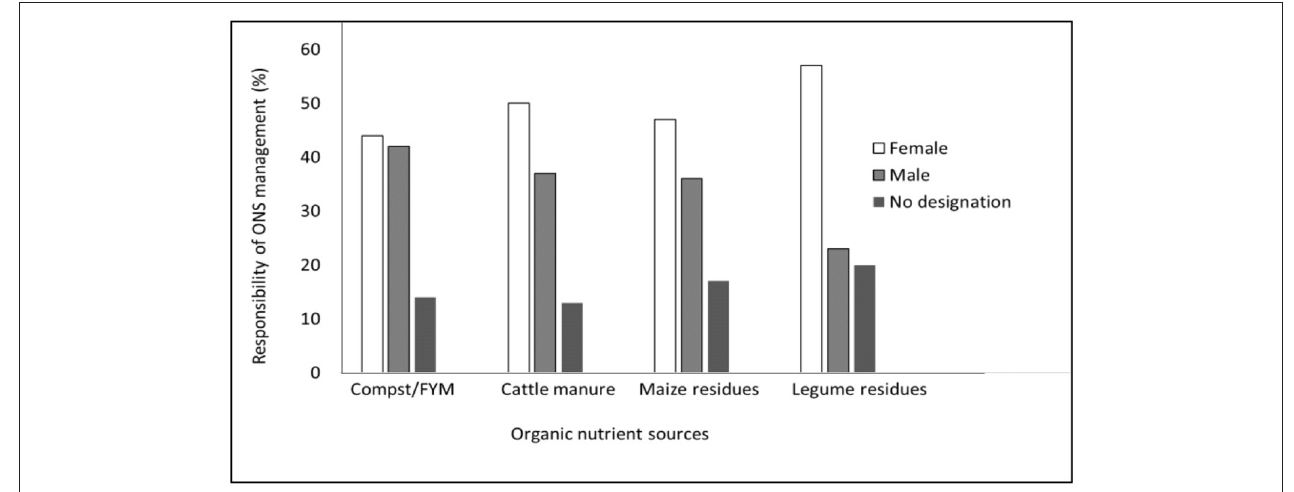
FIGURE 2 | Management responsibility of organic nutrient sources separated by gender in households of Busia, Nandi, and Vihiga counties in western Kenya. Number of households producing compost/Farmyard manure(FYM) = 113; number of households with Cattle manure = 167; number of households with maize residues = 180; number of households with legume residues = 160.